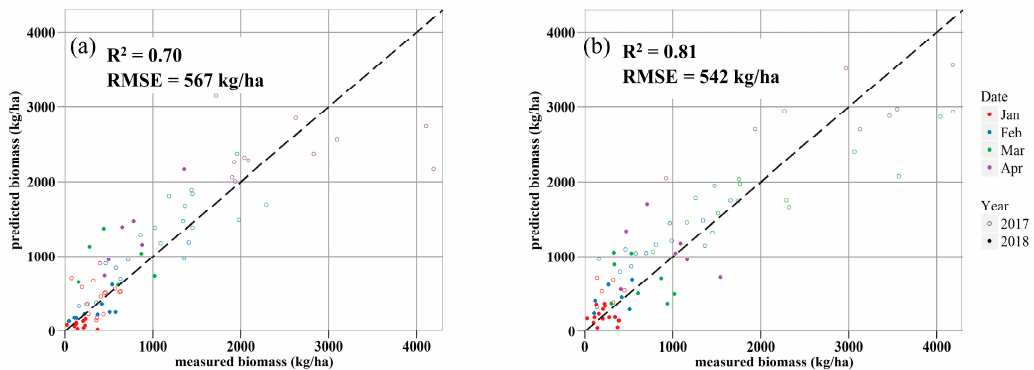
Figure 8. Biomass predicted by models with LUE optimized as functions of ( a ) elevation and IC (Model I); and ( b ) elevation, IC, and air temperature and soil moisture stress terms (Model II). Each point represents a pair of the predicted and observed biomass from the validation dataset.